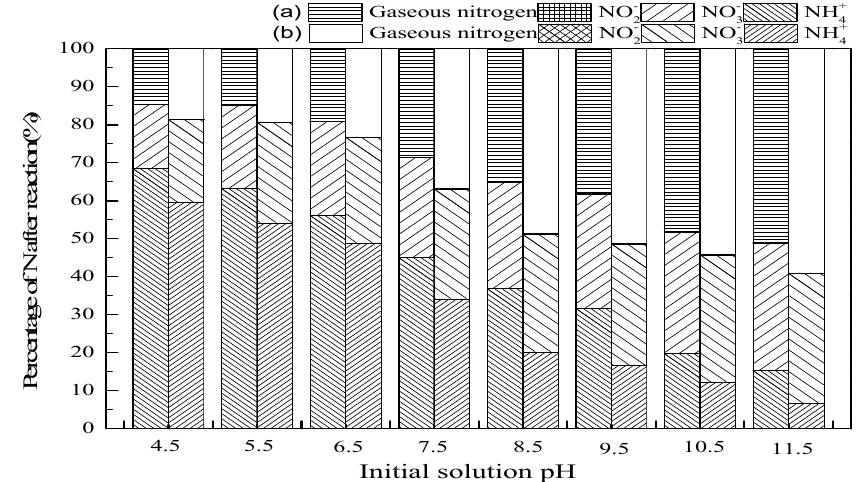
Figure 3. The e ff ect of initial solution pH on ammonia conversion. Reaction conditions: initial NH 4 + concentration 50 mg / L, initial pH 4.5 to 11.5, ozone flow 1.5 g / h, catalytic dosage 2.0 g / L, temperature 25 ◦ C reaction time 60 min, ultrasonic frequency 25 kHz, ultrasonic power 270 W, ultrasonic operation 1 s and interval 2 s. ( a ) SrO-Al 2 O 3 / O 3 , ( b ) SrO-Al 2 O 3 / US / O